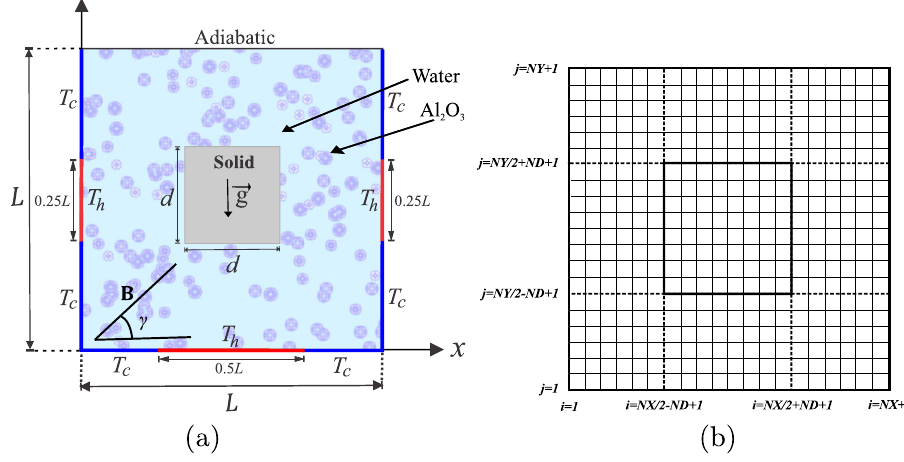
Figure 1. ( a ) Physical model of convection in a square cavity, and ( b ) grid-points distribution in the adiabatic inner block ( NY /2 − ND + 1 ≤ j ≤ NY /2 + ND + 1, NX /2 − ND + 1 ≤ i ≤ NX /2 + ND +